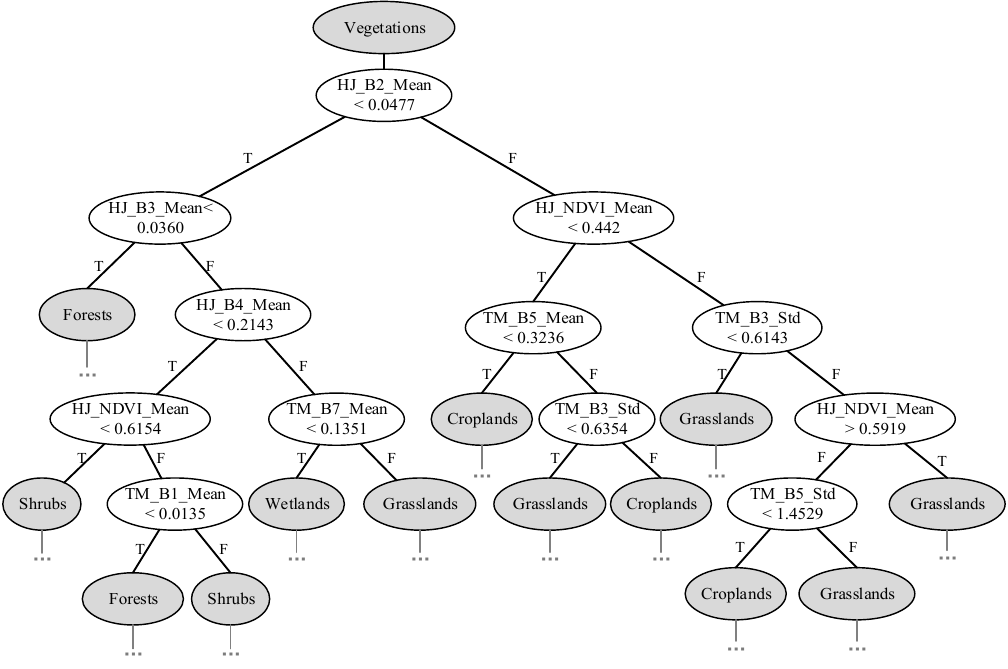
Figure 7. The decision tree for vegetation division. The Landsat TM image acquired on 28 September 2010. The Bx denotes x-th band of satellite image, the Std denotes the standard deviation.